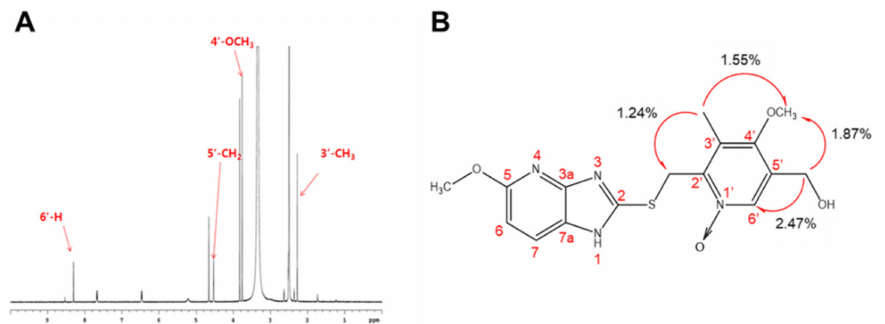
Figure 4. Characterization of a major metabolite of tenatoprazole, 1 (cid:48) - N -oxy-5 (cid:48) -hydroxytenatoprazole sulfide. ( A ) 1 H NMR spectrum of 1 (cid:48) - N -oxy-5 (cid:48) -hydroxytenatoprazole sulfide corresponding to peak 4 of Figure 2 and metabolite M4 of Tables 1 and S1. ( B ) Key NOE results of 1 (cid:48) - N -oxy-5 (cid:48) - hydroxytenatoprazole